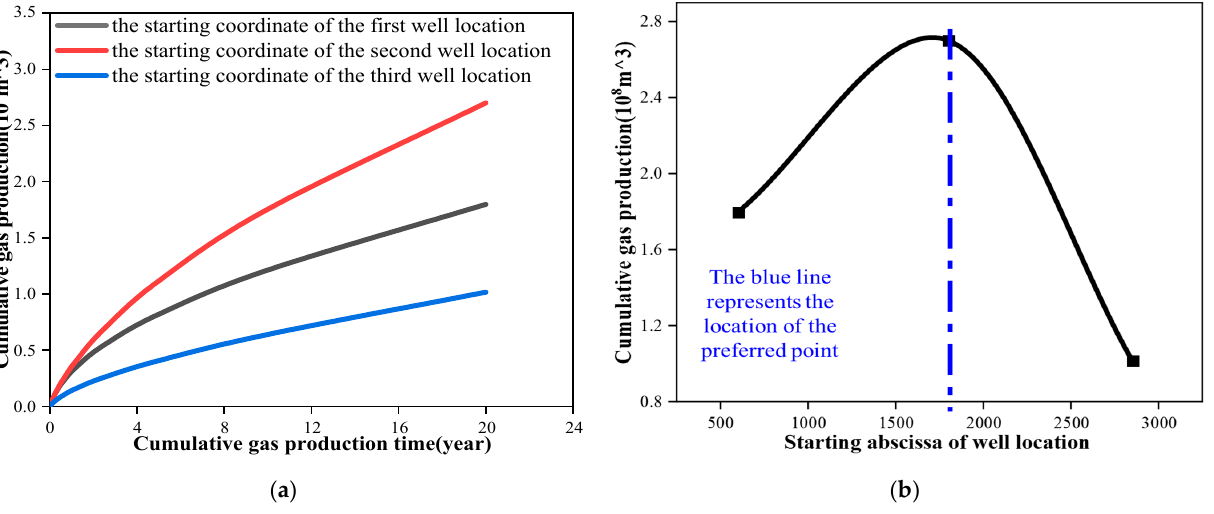
Figure 10. ( a ) Comparison of cumulative production under different well locations and ( b ) schematic diagram of optimization of well location.